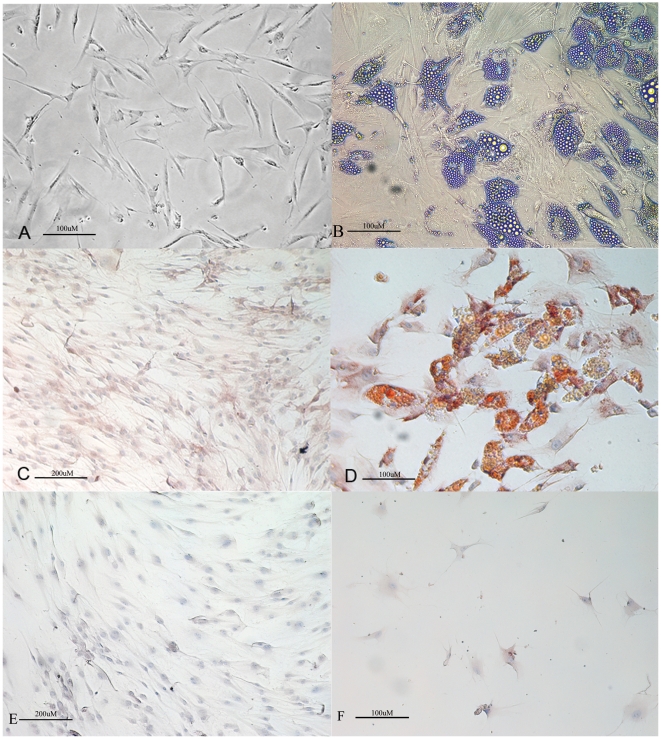
Adipogenic differentiation.(A) ASCs in DMEM 10% FBS exhibit a fibroblast-like morphology (Original magnification 100×); (B) ASCs in adipogenic medium exhibit an adipocyte morphology (Original magnification 100×); (C) CD34+/CD90+ cells in DMEM 10% FBS showing negativity for adiponectin by immunohistochemistry (Original magnification 400×); (D) CD34+/CD90+ cells in adipogenic medium showing positivity for adiponectin by immunohistochemistry (Original magnification 100×); (E) CD34−/CD90− cells in DMEM 10% FBS showing negativity for adiponectin by immunohistochemistry (Original magnification 100×); (F) CD34−/CD90− cells in adipogenic medium showing negativity for adiponectin by immunohistochemistry (Original magnification 400×).